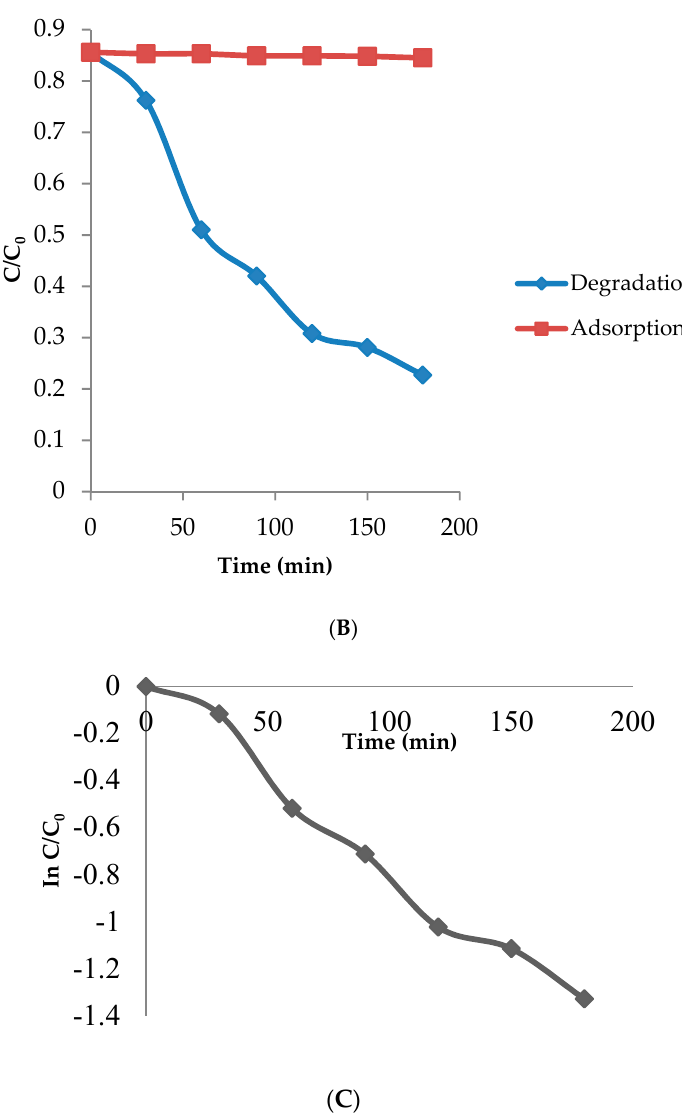
Figure 4. ( A ) Degradation of methylene blue under solar irradiation in the presence of DSAgNPs, ( B ) Photocatalytic degradation efficiency of DSAgNPs ( C ) Pseudo-First order kinetics.